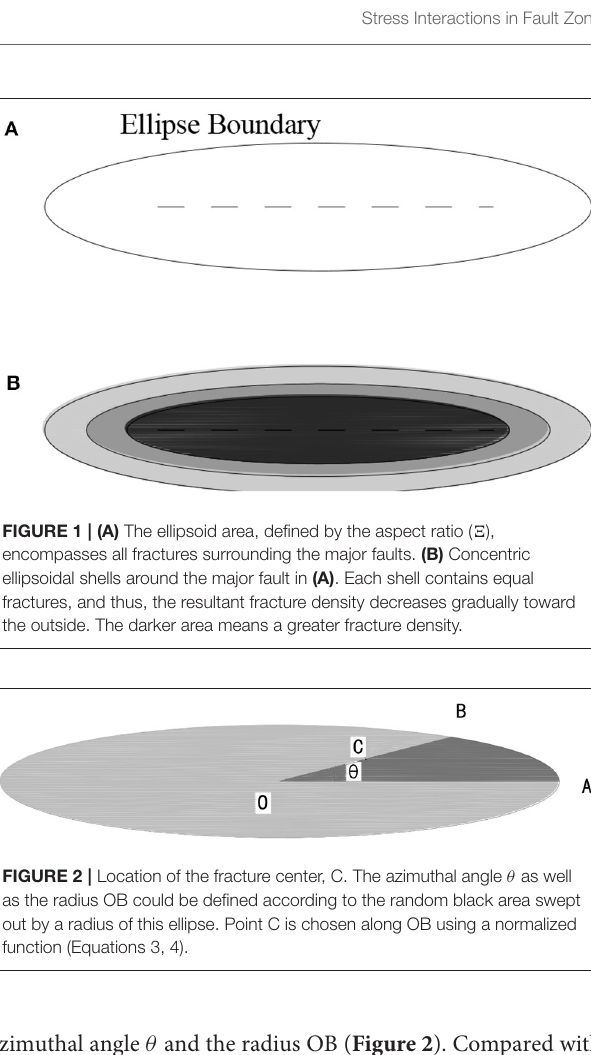
azimuthal angle θ and the radius OB ( Figure 2 ). Compared with the adoption of the random angle, the use of the swept area (black zone in Figure 1 ) would produce a bias toward the major axis of the ellipse, which is more representative of the natural fault